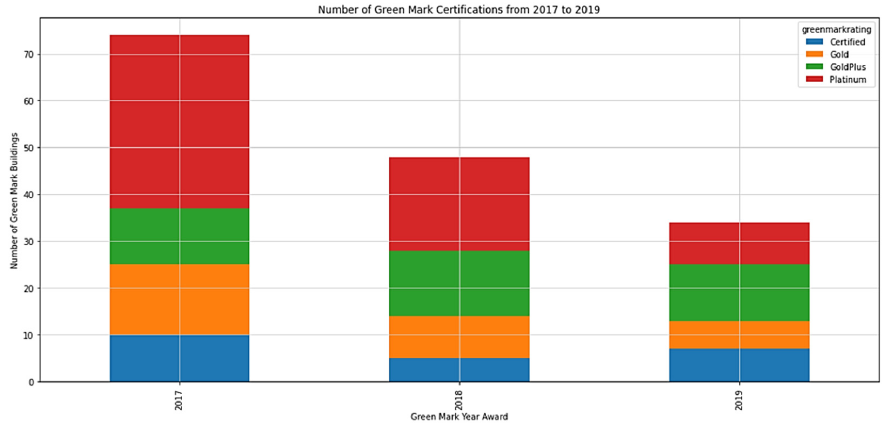
Figure 10. Number of registered Green Mark buildings from 2017 to 2019.